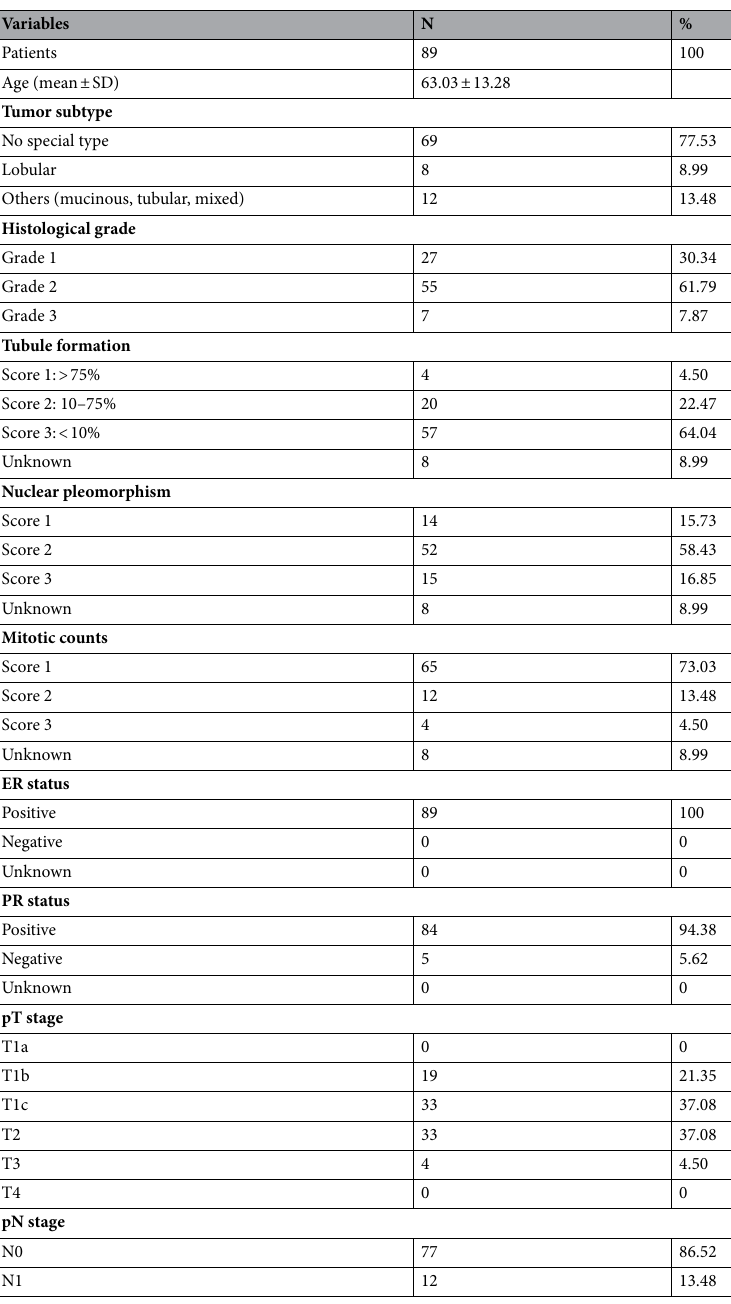
Table 1. Clinicopathological